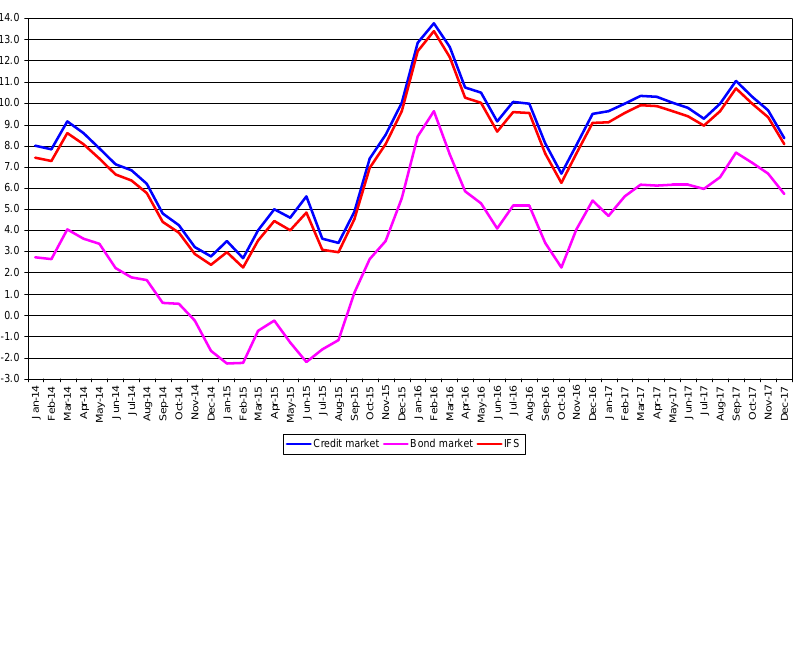
Figure 1. Dynamics of the general stability index (IFS), indices of credit market and bond market